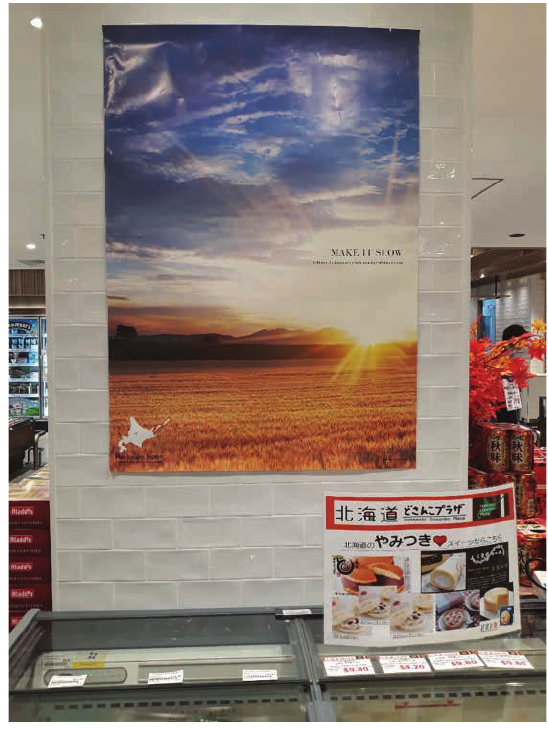
Figure 4: Fall sunrise- Hokkaido Tourism Association